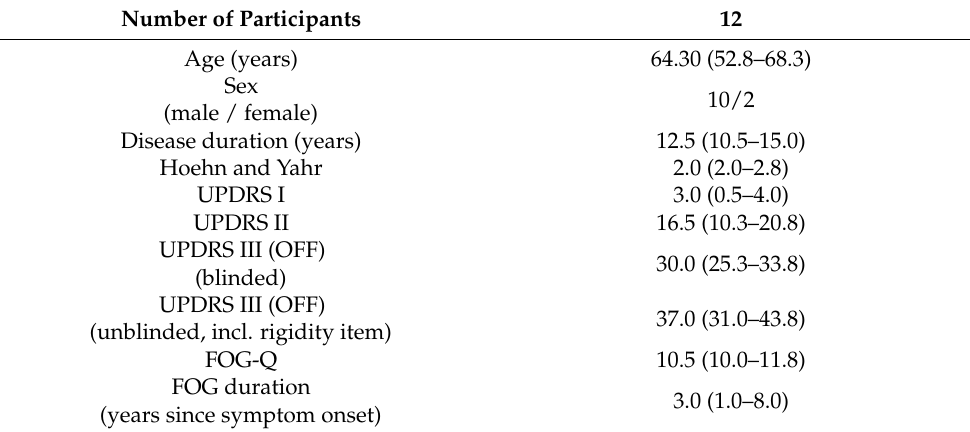
Table 1. Demographics and disease